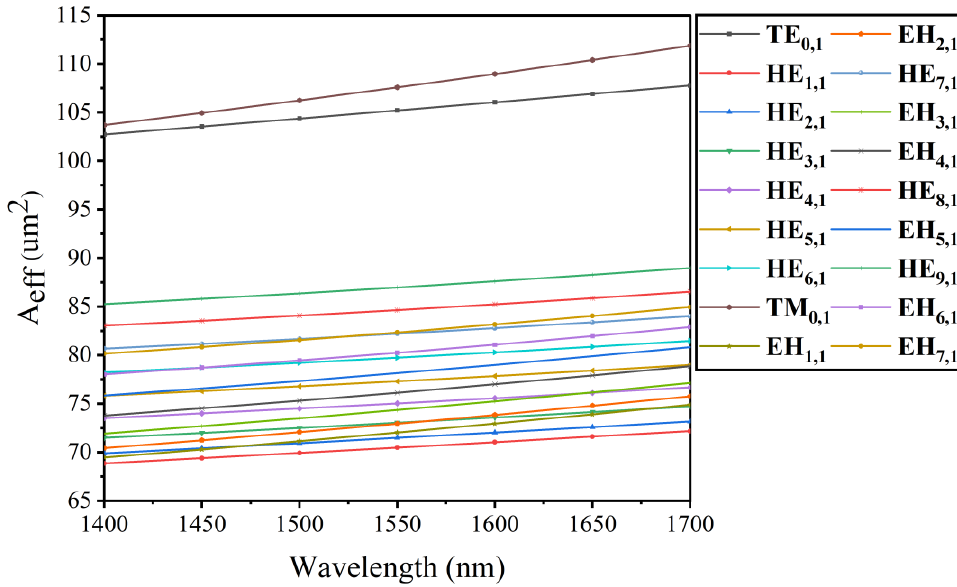
Figure 10. The relation between EMFA and wavelength in different vector modes.